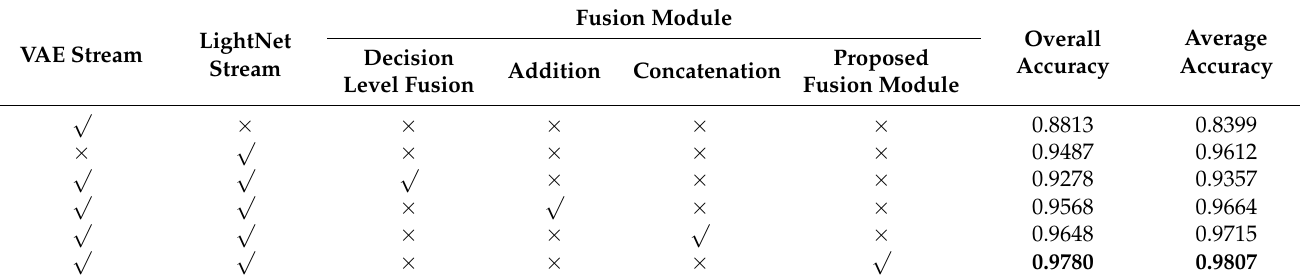
Table 8. Ablation Study.